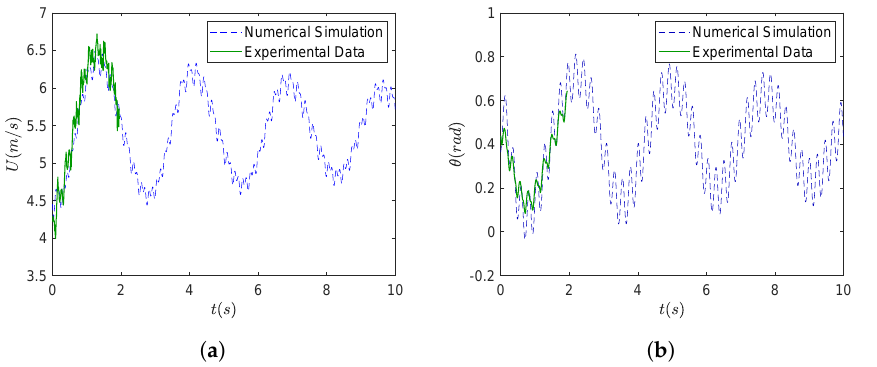
Figure 5. Comparison between numerical and experimental evolutions. ( a ) Airspeed; ( b ) pitch